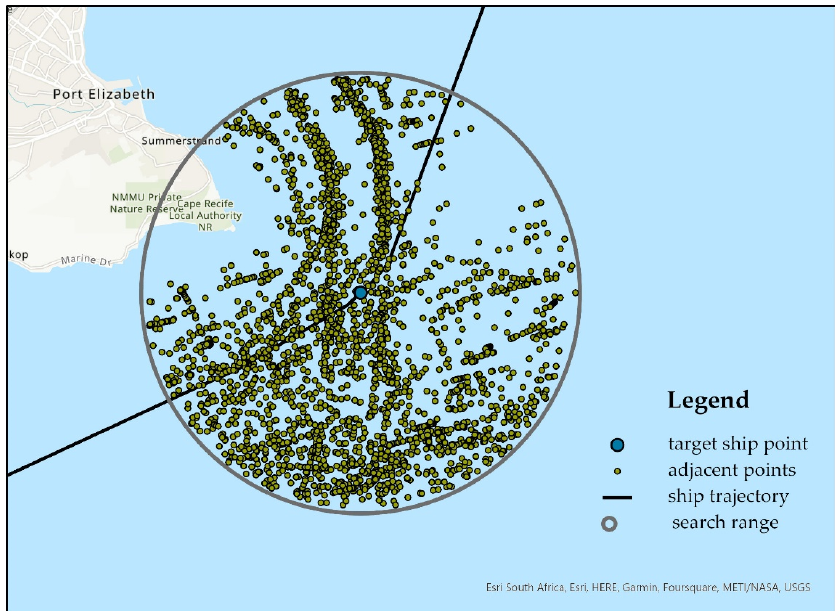
Figure 3. Example of searching adjacent points in the expanded area for target